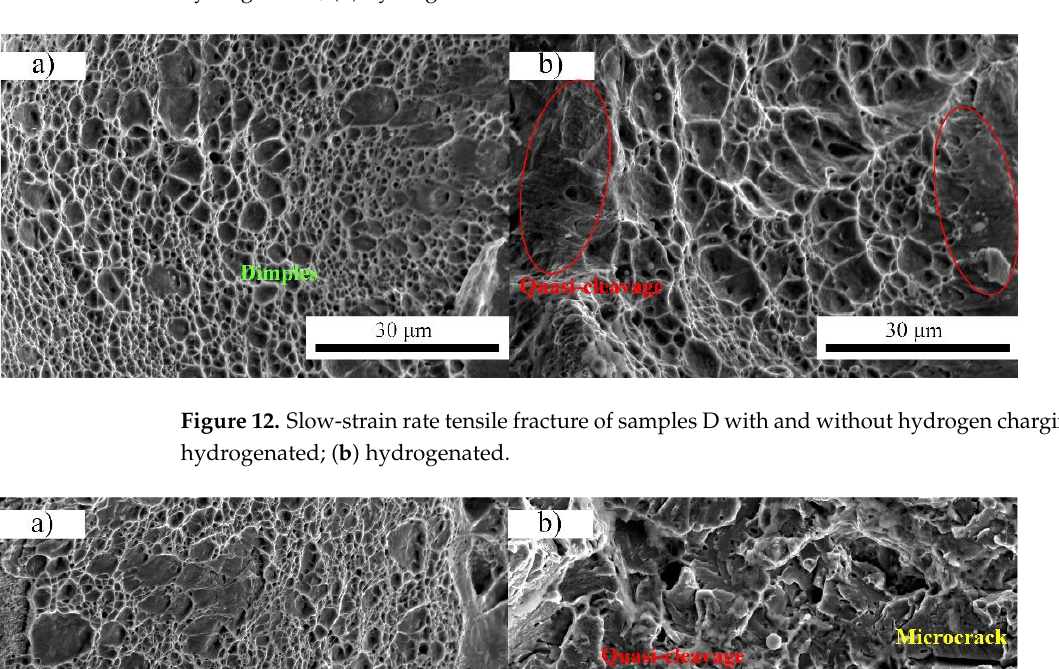
Figure 11. Slow-strain rate tensile fracture of samples C with and without hydrogen charging. ( a ) Not hydrogenated; ( b ) hydrogenated.